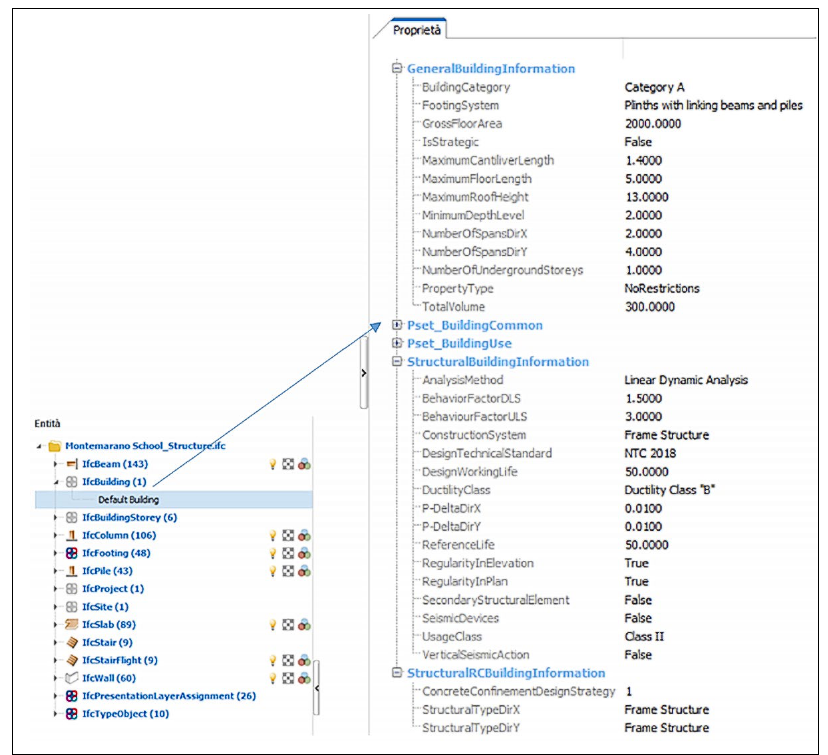
Figure 9. The Pset adds information on the structural project at the global level to the ifcbuilding